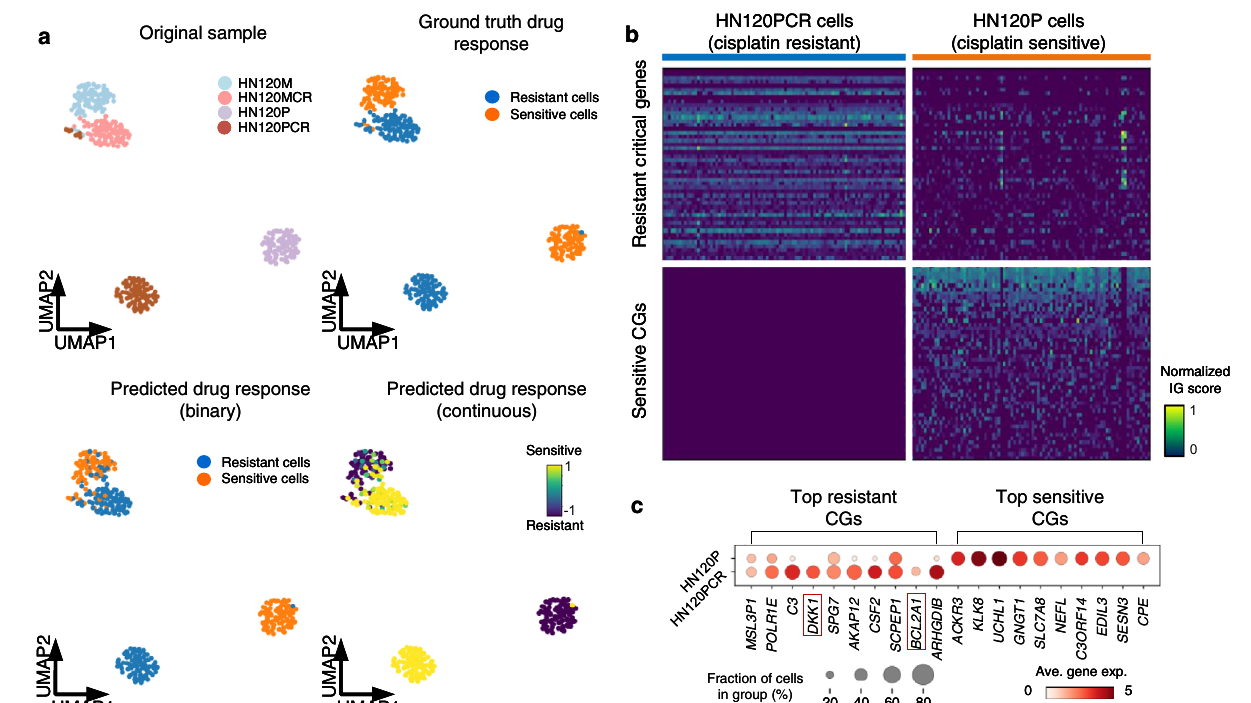
Fig. 4 | Case study of scDEAL on Data 1 with Cisplatin drug responses. a UMAP comparison between ground-truth labels and predicted binary response labels in scDEAL. b Integrated gradient heatmap of top 50 CGs in the HN120P cell group (sensitive)andHN120PCR(resistant)cellgroup.CGsinHN120Pwereconsideredas